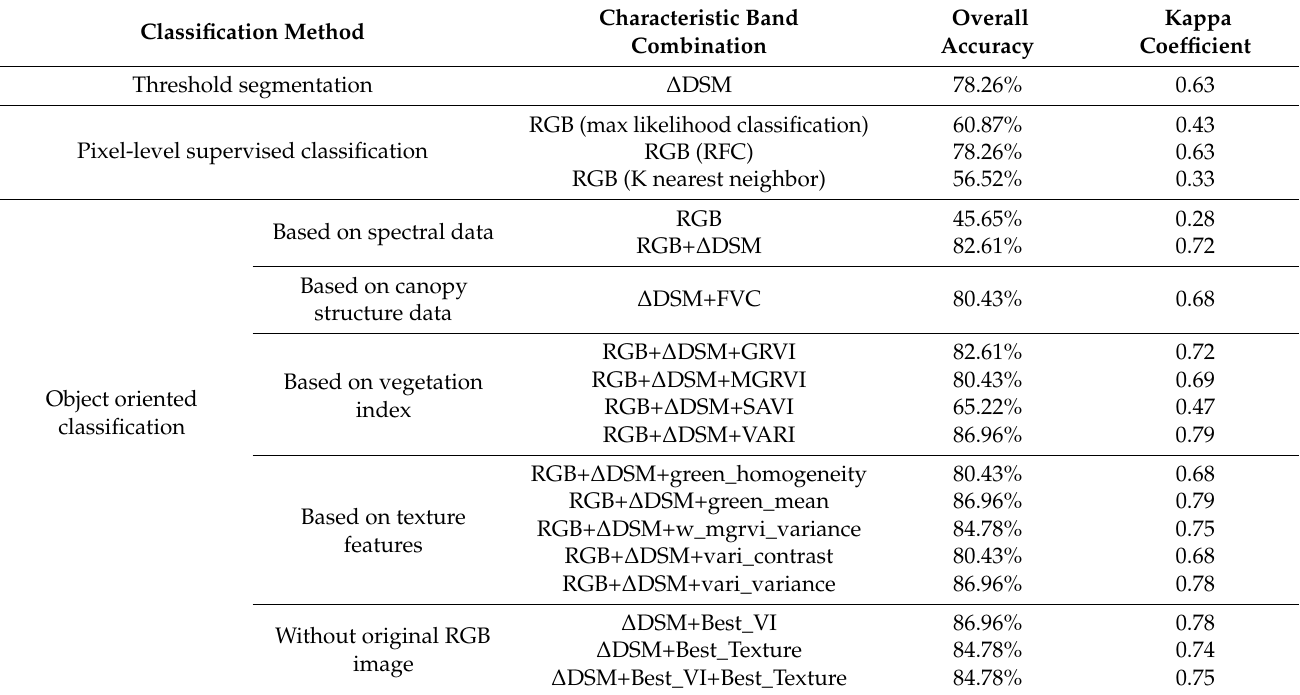
Table 5. Classification accuracy for various classification methods and combinations of characteristic